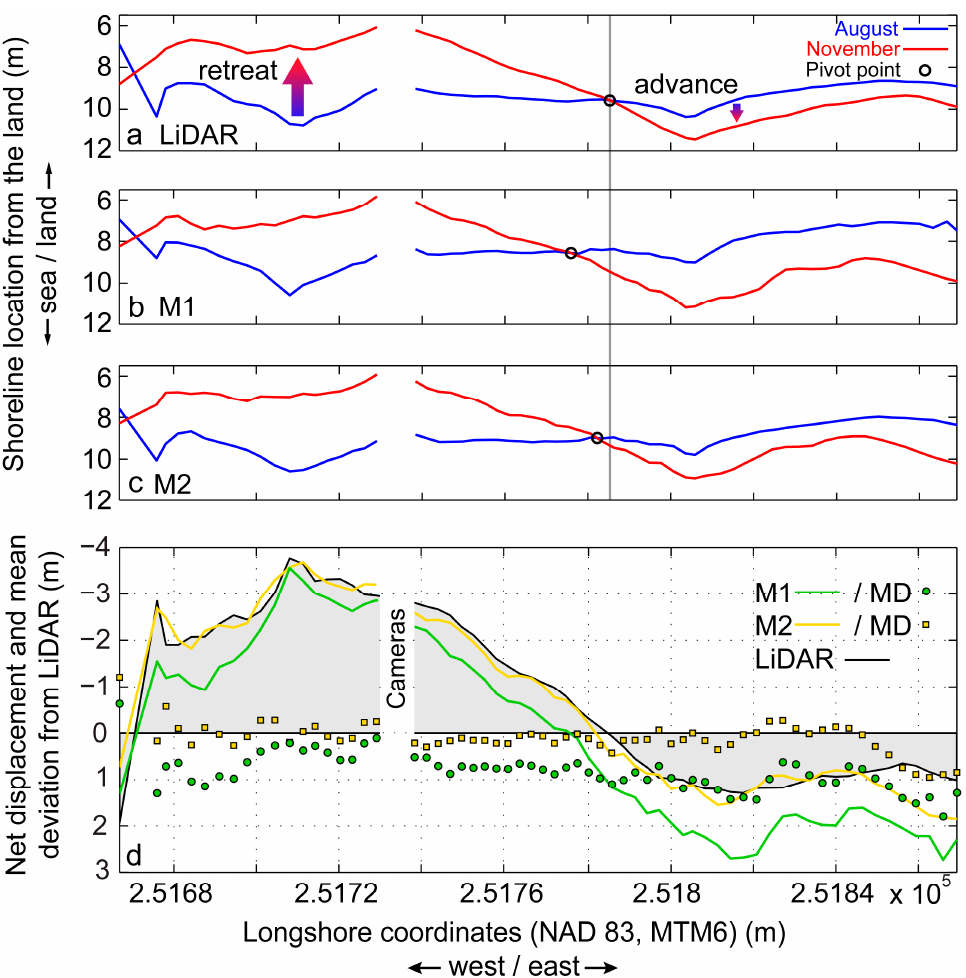
Figure 12. Longshore variation of the cross-shore position of the reference shoreline (1.19 m elevation contour) obtained during the surveys. The patterns of erosion/advance observed with the LiDAR surveys ( a ) are also distinguished with both M1 ( b ) and M2 ( c ), but the net displacement ( d ) is best fitted by the M2 model (yellow curve, panel d). Dots show the mean deviation (MD) of the data. The pivotal point of the beach as detected with M2 is closely located to the smoothing window size (~5.25 m) (black circles, panels a–c).